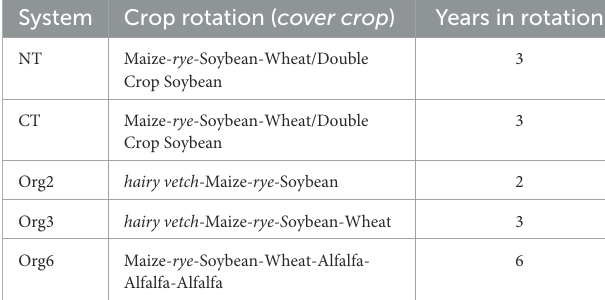
TABLE 1 Cropping systems and crop rotations (including cover crops) at the USDA-ARS Farming Systems Project (FSP). System Crop rotation ( cover crop